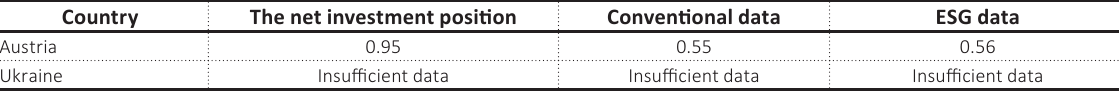
Table 5. Persistence analysis: the case of Ukraine and Austria